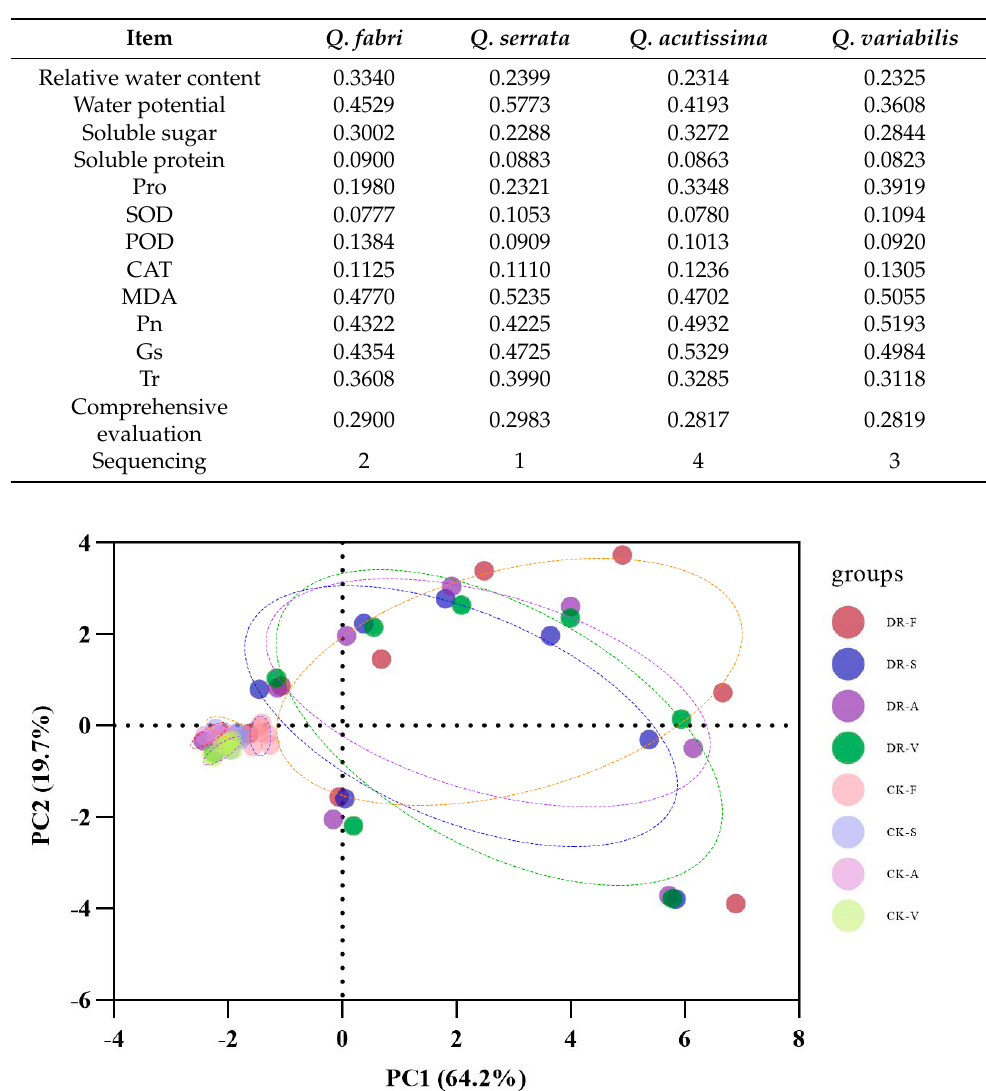
Table 2. Membership function values and evaluation index of the drought resistance of four oak species.